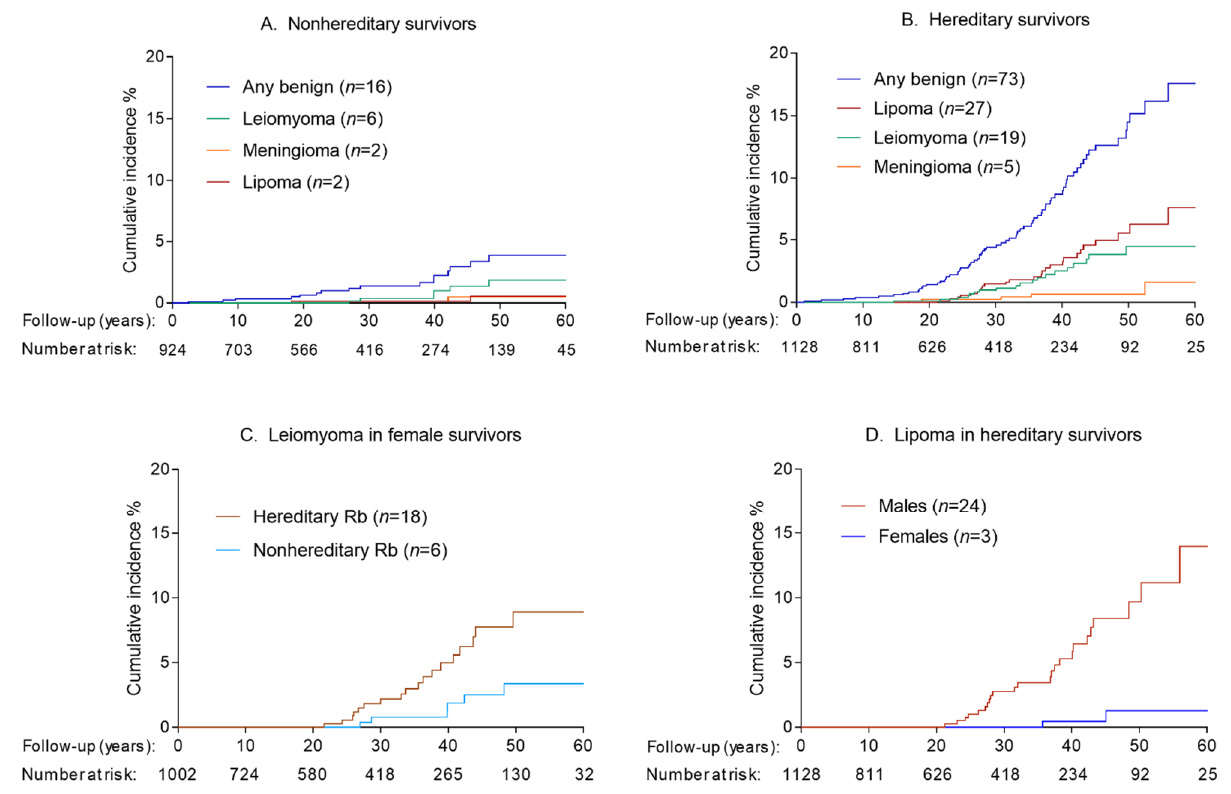
Figure 1. Cumulative incidence of first benign tumors in retinoblastoma survivors by time since retinoblastoma diagnosis. Patients were followed until first benign tumor diagnosis or date of last questionnaire (patients who never completed a questionnaire were censored at the earliest of death or date of medical record abstraction). All analyses account for competing risk of death. Type-specific analyses further accounted for competing risk from diagnosis of another type.